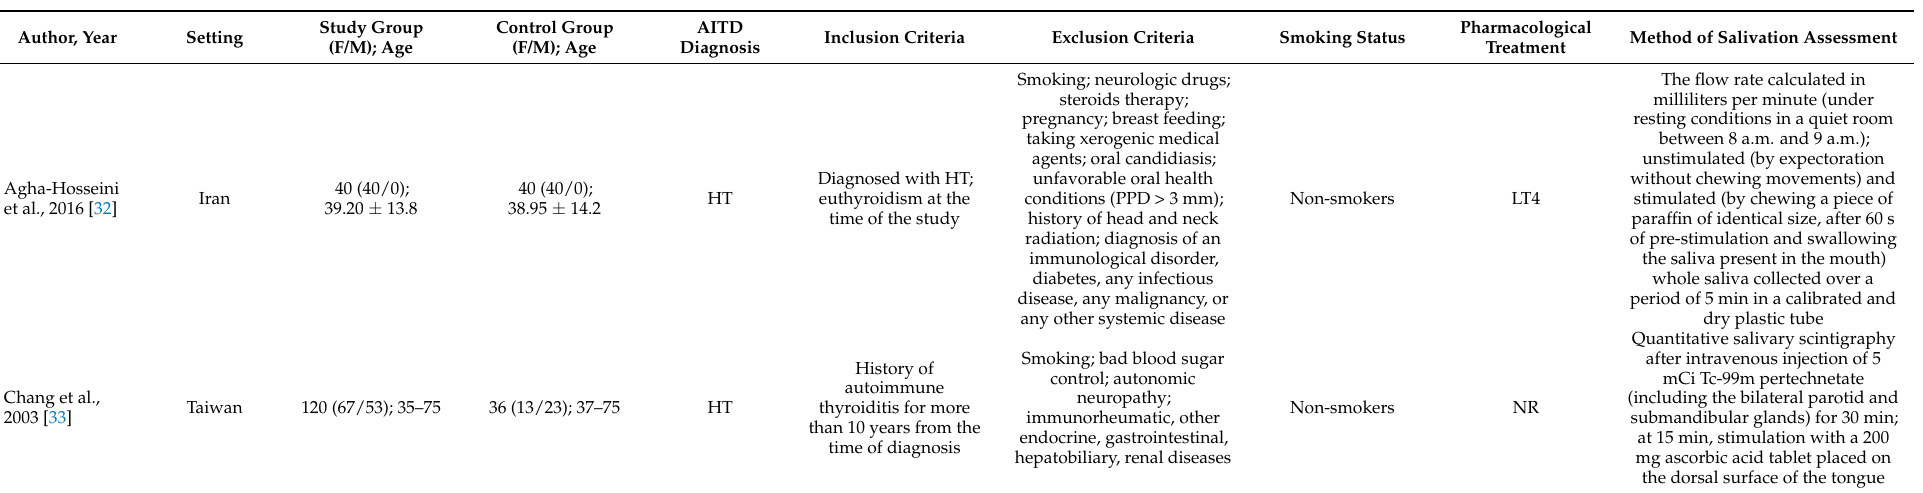
Table 4. Characteristics of included studies considering only quantitative assessments of